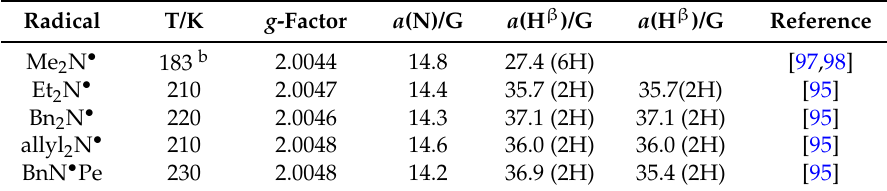
Table 4. Isotropic EPR parameters for selected dialkylaminyl radicals R 2 N • a .